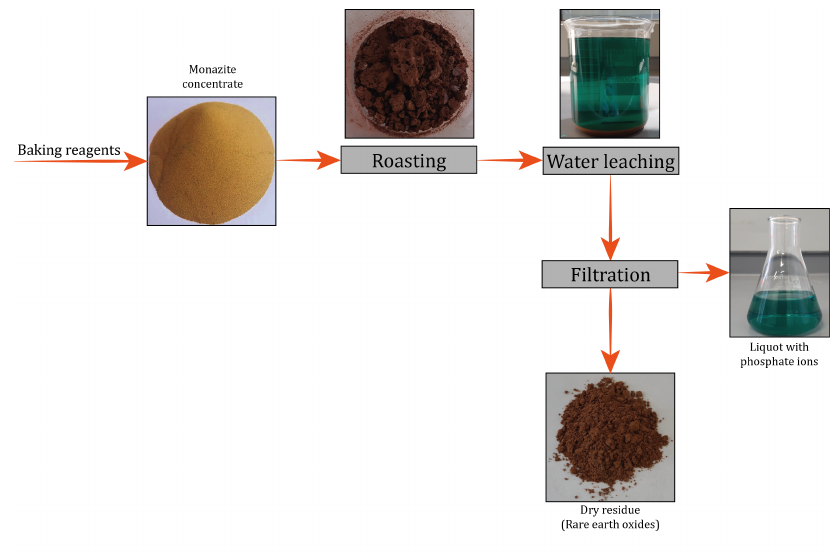
Figure 5. Flowsheet for the separation of phosphate from monazite concentrate via treatment with KOH . (Done by the